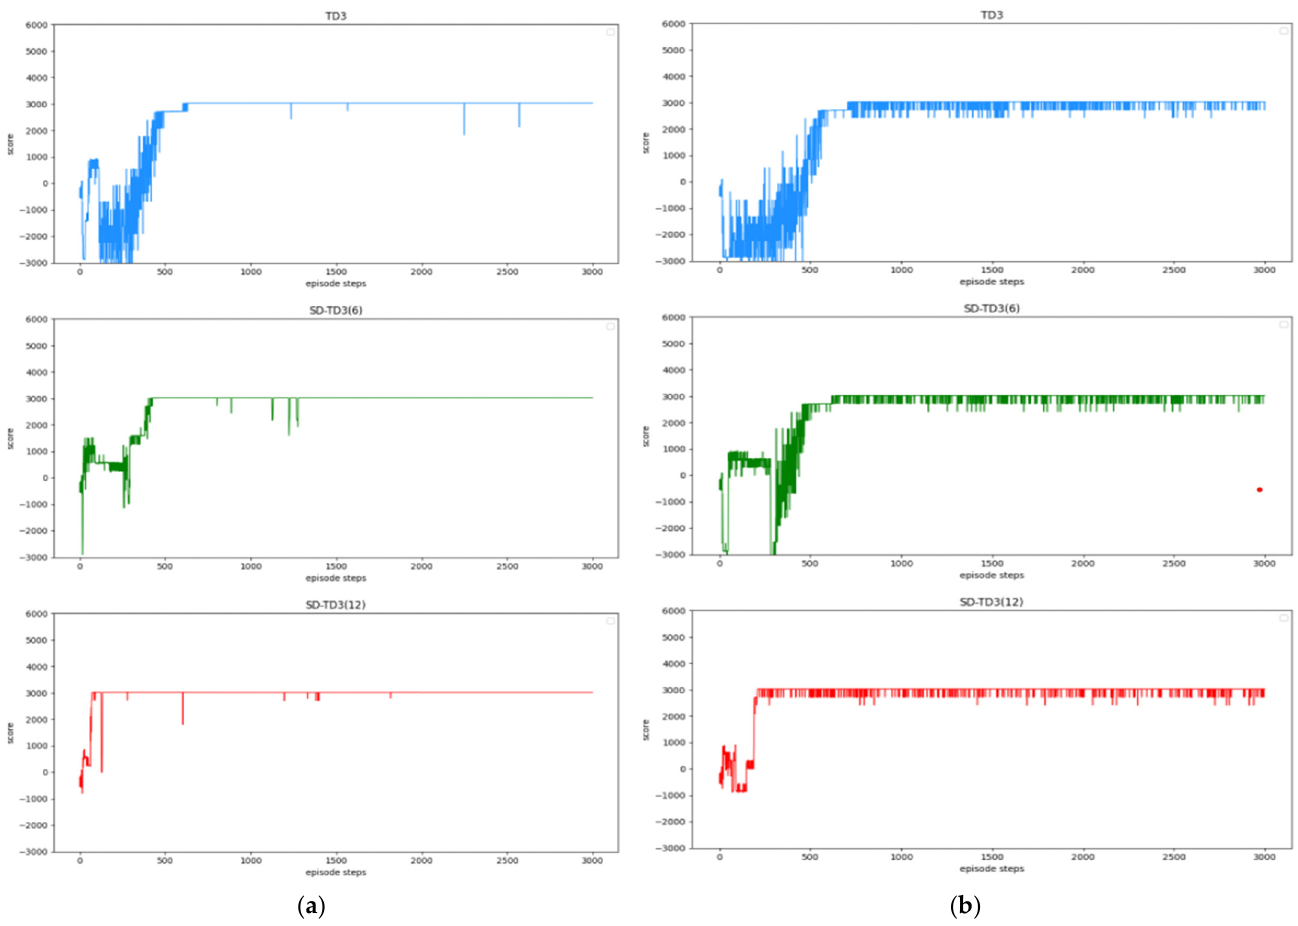
Figure 11. The best training results of the three algorithmic models. ( a ) Best training results of the model in environment 1; ( b ) Best training results of the model in environment 2.